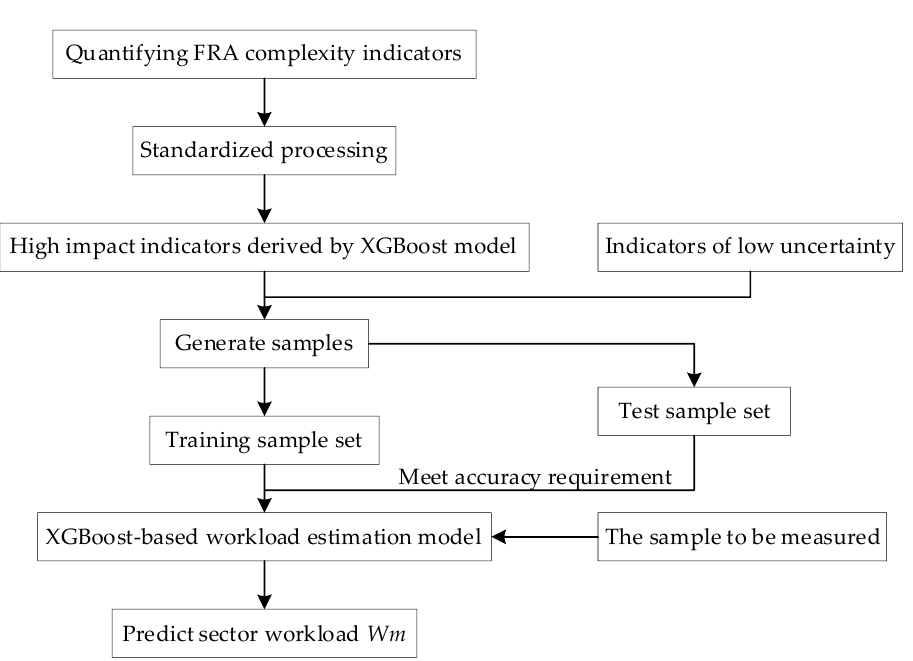
Figure 1. Flowchart of sector workload estimation based on